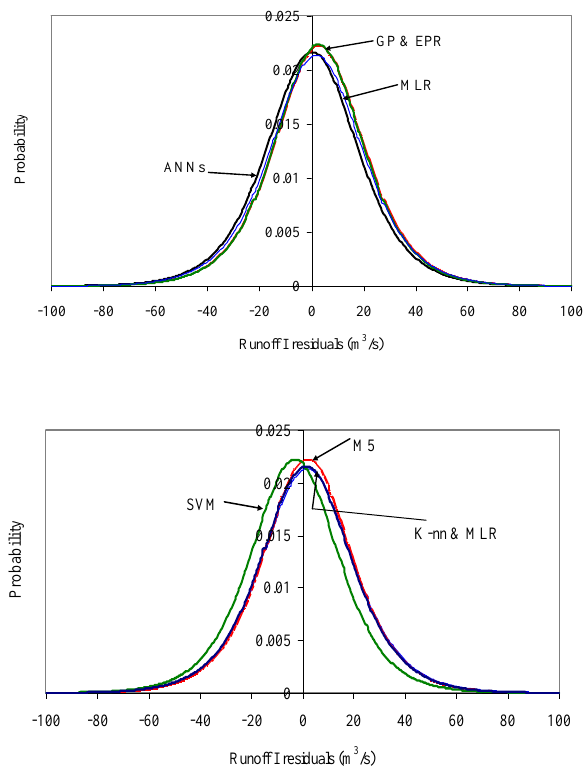
Fig. 10. Probability distribution of the 12 model residuals of all techniques (rainfall-runoff I case study).